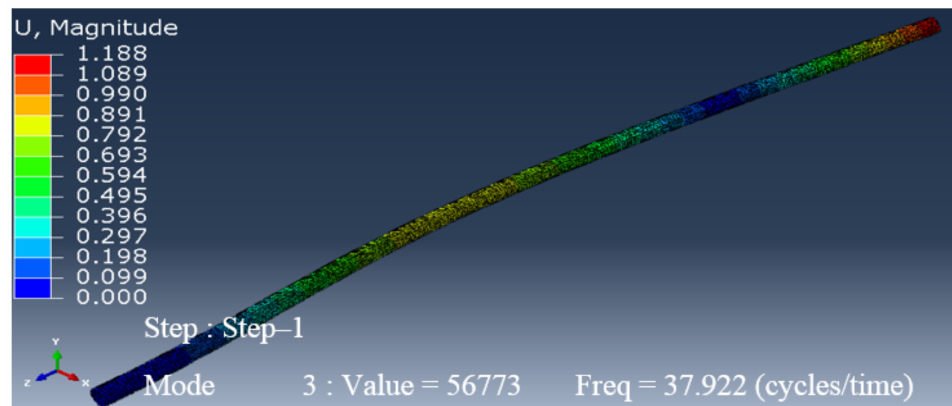
Figure 4. Second natural frequency of an undamaged pipe.